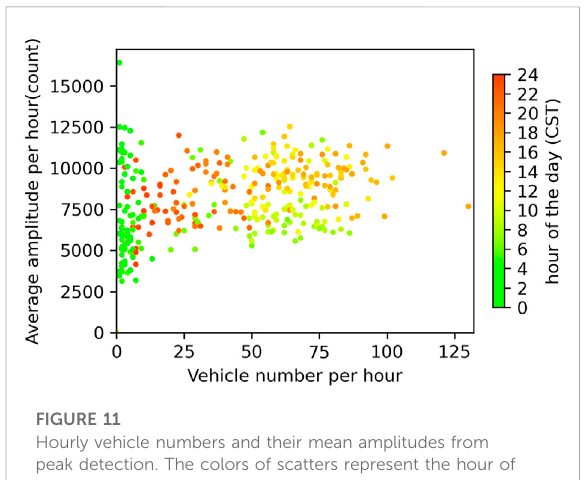
FIGURE 11 Hourly vehicle numbers and their mean amplitudes from peak detection. The colors of scatters represent the hour of the